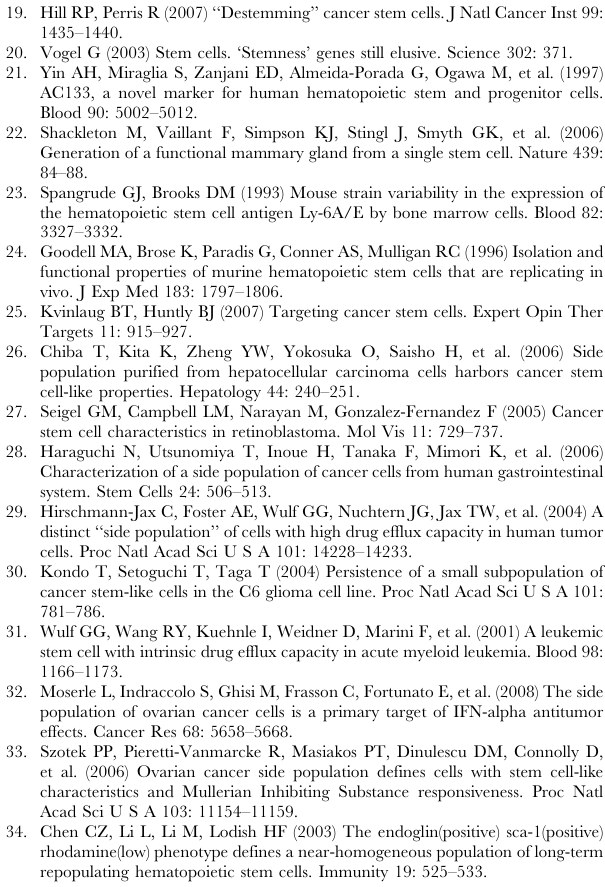
Figure S2 Representative graph for the SP and MP sort from ascites samples. (DOC) Figure S3 Pearson’s and Spearman’s analysis graph. (DOC) Figure S4 Western Blot Analysis of FPGT expression in SP and